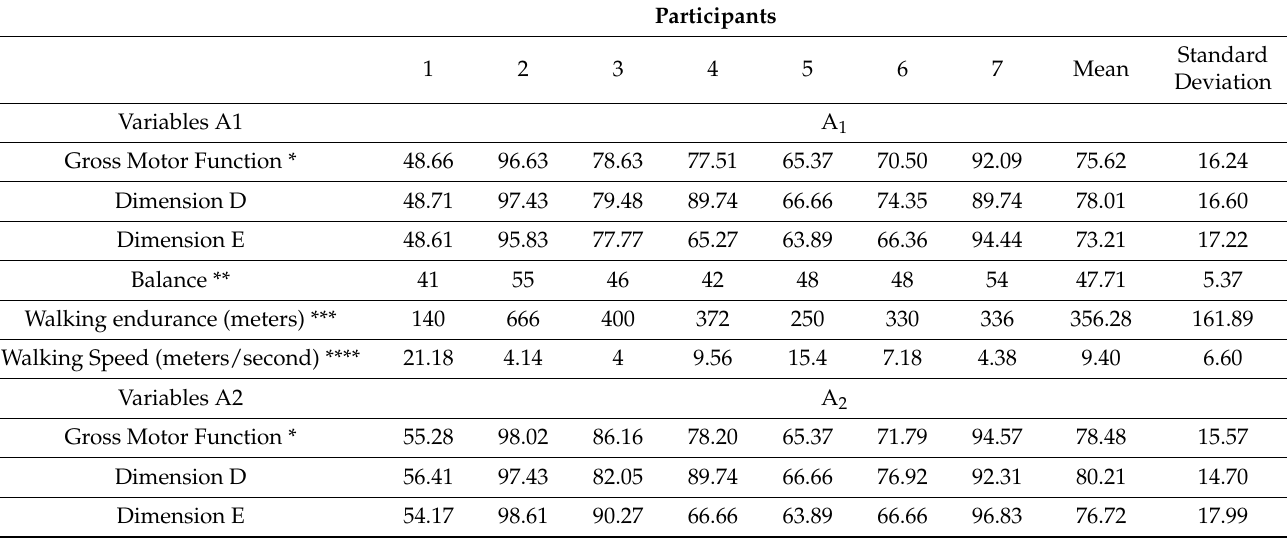
Table 2. Description of outcome